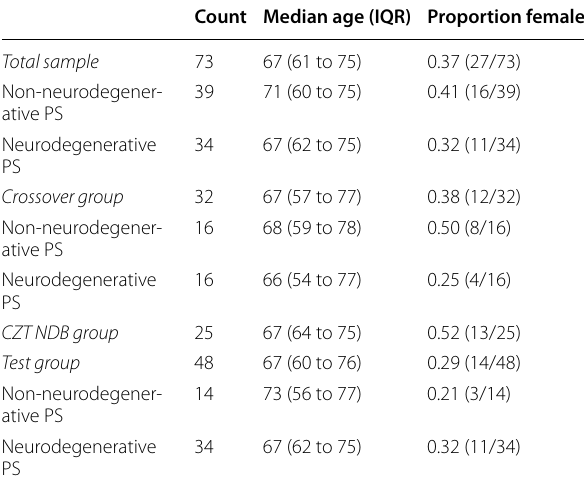
Table 1 Age and gender balance of the individuals in all subgroups. Age difference between the NDB and test group was not significant (Mann–Whitney U test, p =